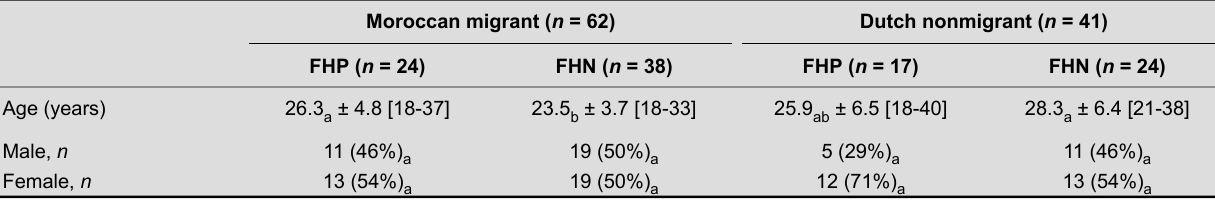
Age and Gender of Study Participants as a Function of Migration Status and Family History (N =